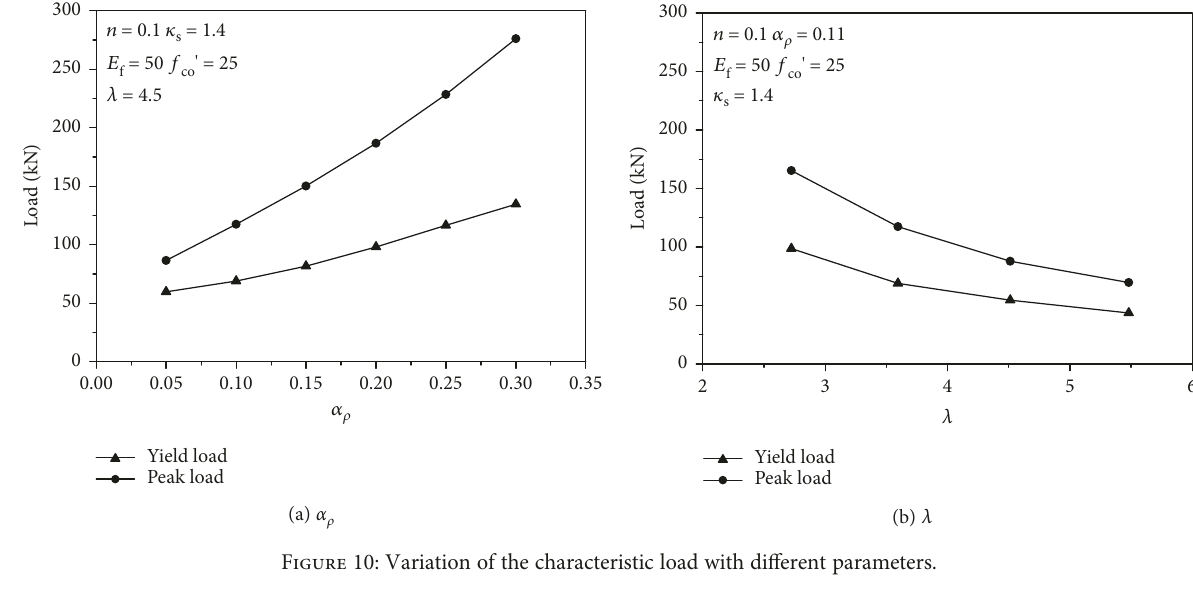
Figure 10: Variation of the characteristic load with di ff erent parameters.